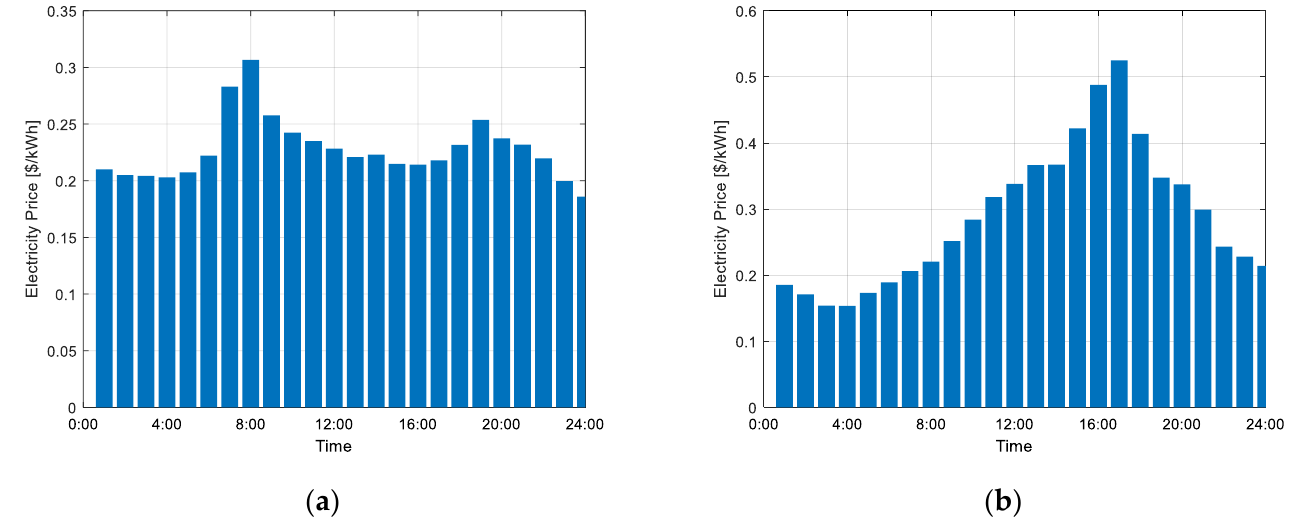
Figure 7. Electricity price curve on ( a ) a winter ’s day and ( b ) a summer ’s day.